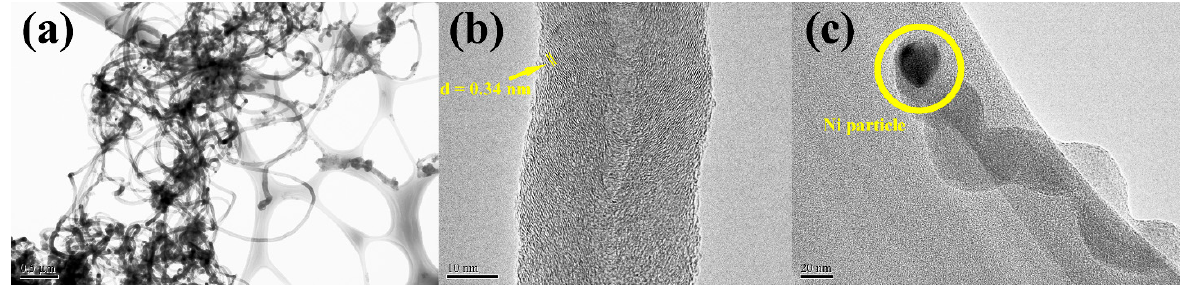
Figure 2. ( a ) Low-magnification TEM image of CNTs, and HRTEM images of ( b ) body and ( c ) head of CNT.